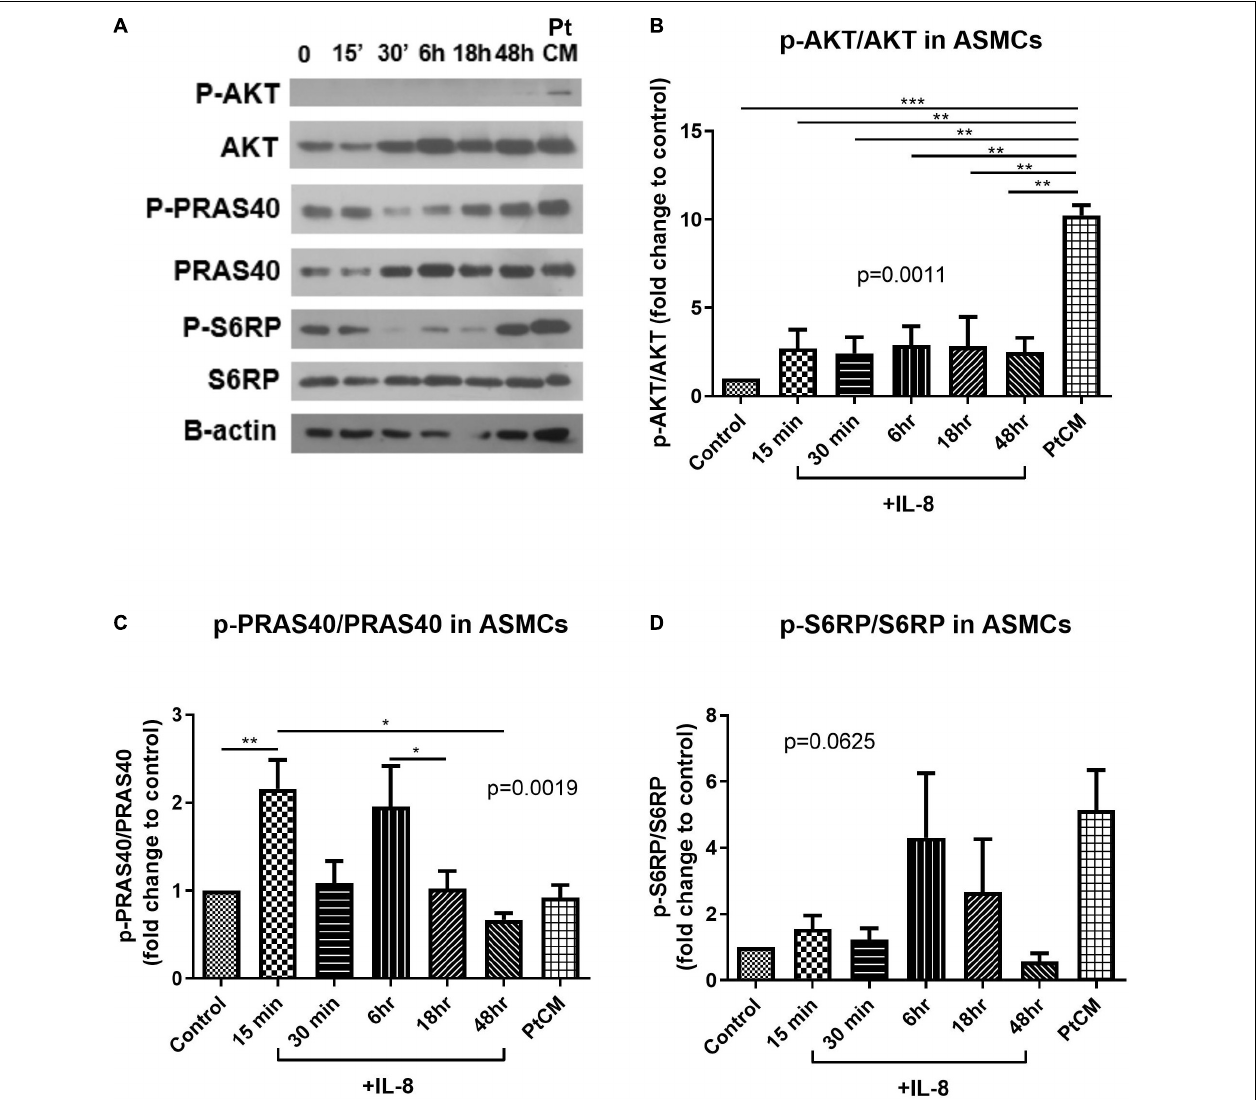
FIGURE 6 | AKT-PRAS40-mTOR in ASMCs co-cultured with IL-8 or condition medium. (A) ASMCs were stimulated using IL-8 (20 ng/ml) at various time points: 15 (cid:48) , 30 (cid:48) , 6, 18, and 48 h or condition medium from ASMC co-cultured with FCs from patients (Pt CM, 3:1 dilution with culture medium. 6 h treatment). (B) Phosphorylation status of AKT, (C) PRAS40 and (D) ribosomal protein S6 (S6RP) in ASMCs following stimulation by IL-8 or PtCM ( n = 5 ∼ 6). * P < 0.05; ** P < 0.01; *** P <